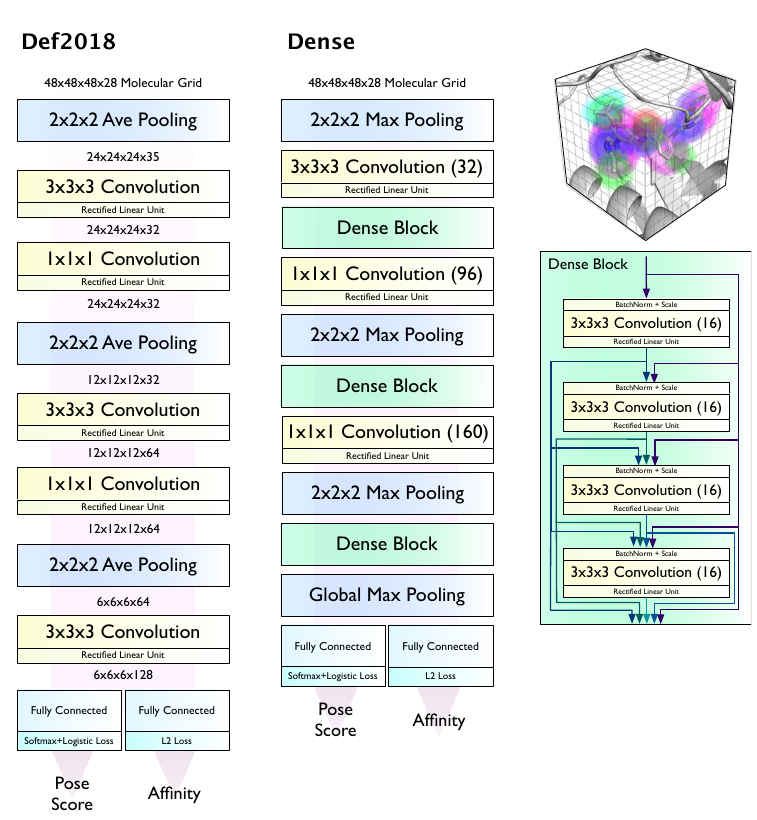
Figure 1. Voxelized grid-based CNN architectures evaluated in this